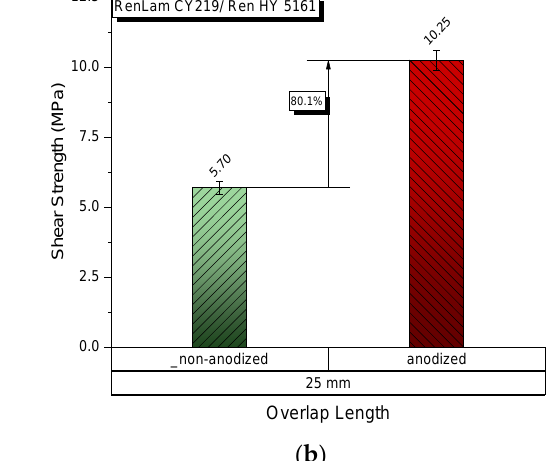
Figure 8. Plots of load against crosshead displacement for the single-lap joint specimens ( a ) for tensile – shear loading and ( b ) for three-point bending loading. 3.2.2. Three-Point Bending of Joints with Araldite Adhesive Since single-lap joints, when in service, may be loaded under tension or bending con- ditions and/or under more complex modes, it is important to additionally study the joint behavior under three-point bending loading. Another reason for studying the bending behavior of joints is that this type of joint loading is not well documented as tensile – shear loading. If the adhesive thickness is kept at 0.02 mm, and the joint width at 18 mm, the effect of increasing the overlap length is to increase the maximum load that can be taken by the joint before the crack initiates, as shown in Table 3. Since the bending moment in the three-